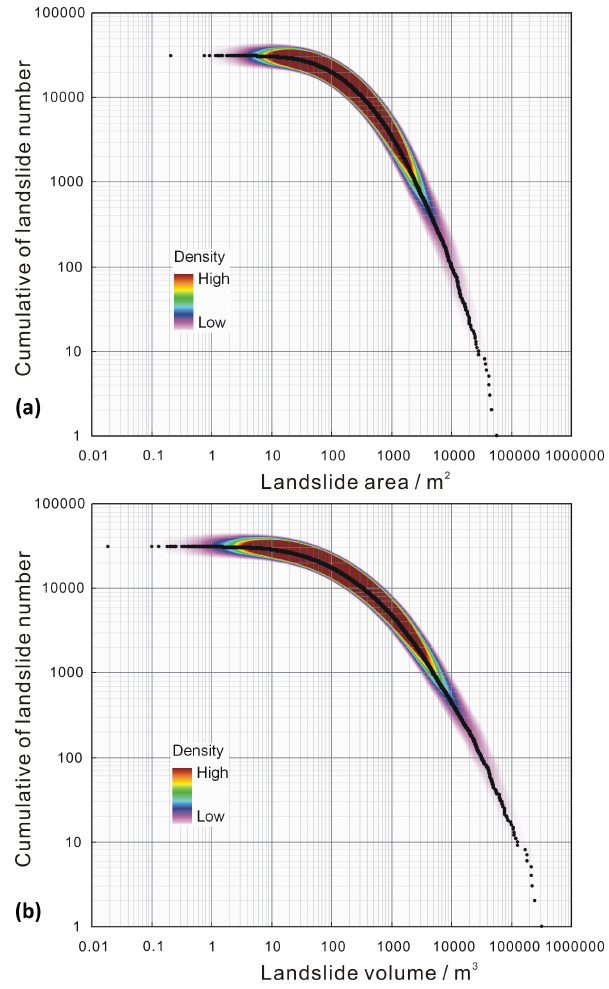
Figure 13. Correlations between cumulative landslide number and landslide scale: (a) landslide area and (b) landslide volume. Density means the density of points projected on the map, which represents the scale distribution of the